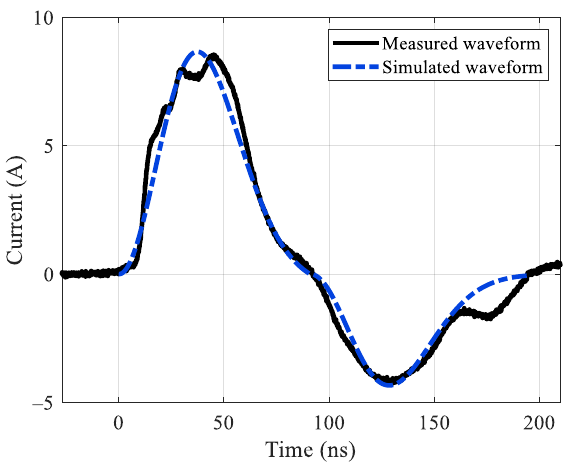
Figure 11. Measured waveform and simulated waveform of discharge current pulse. Measured physical characteristics: t r = 22.98, t w = 45.84, A + = 8.53, A − = 3.88; Calculated mathematical parameters: α = 0.0242, β = 0.0289, t p = 92.91, t e = 185.81; Fitted function parameters: k 1 = 8.064, k 2 = 8.427.